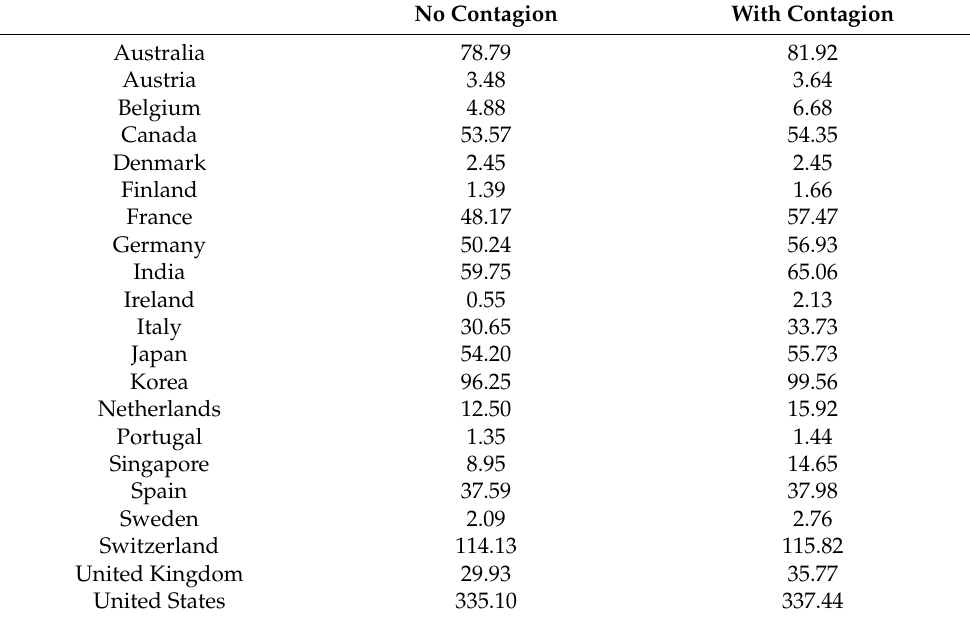
Table 3. Systemic risk contributions (US$ bn.) by